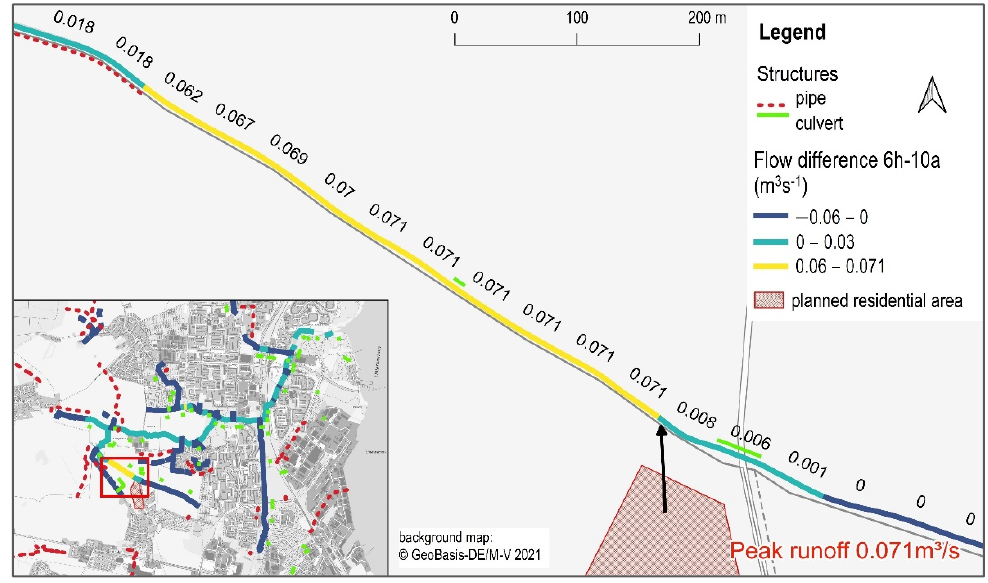
Figure 8. Flow difference (m 3 s − 1 ) in the immediate area of the discharge point for the rain event 6h- 10a (pipes and culverts are plotted with offset to original route).